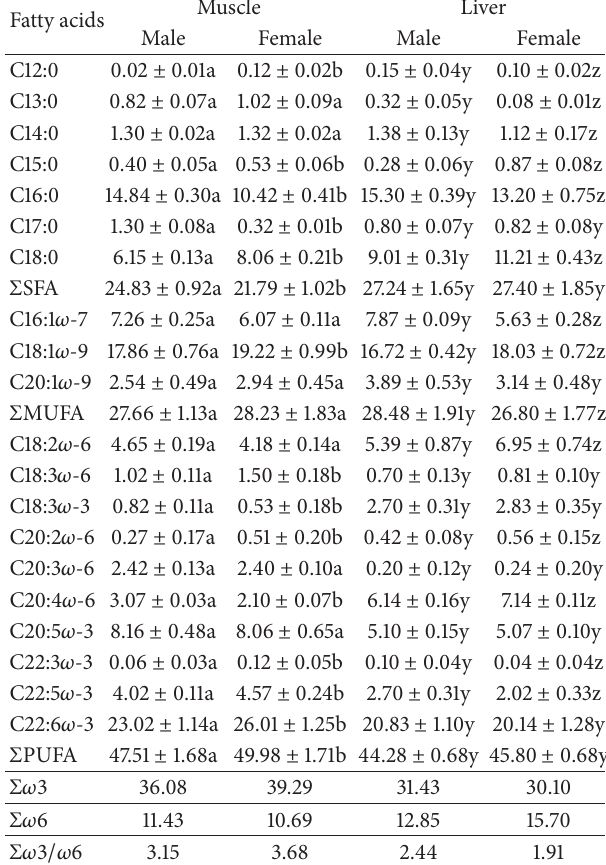
The values are shown as mean ± SD. Mean values are averages of three replicates. Different letters in the same row and values in male and female represent significant statistical differences, 𝑃 < 0.05